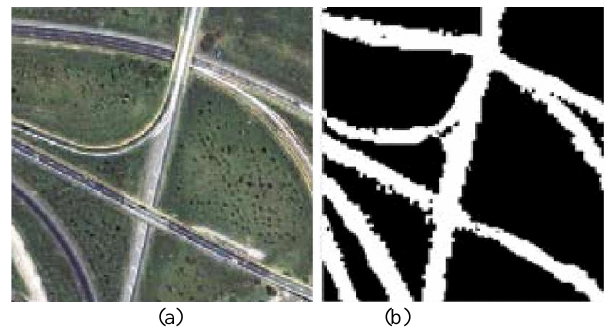
Figure 1. Road map, (a) input data, (b) output road map